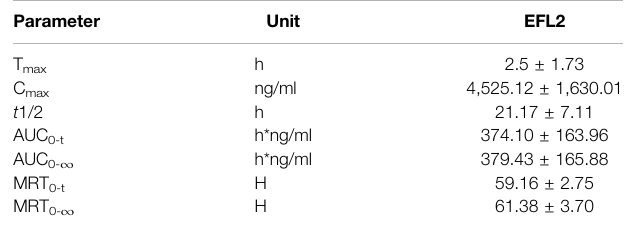
TABLE 1 | Pharmacokinetic parameters of ELF2 in mice after intraperitoneal injection of EFL2 (n (cid:1) 6 for each time points).